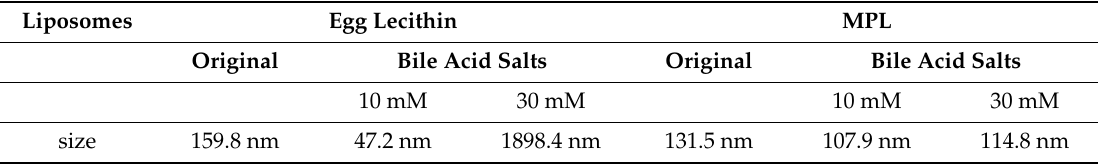
Table 9. The e ff ect of bile acid salts on liposomal size.